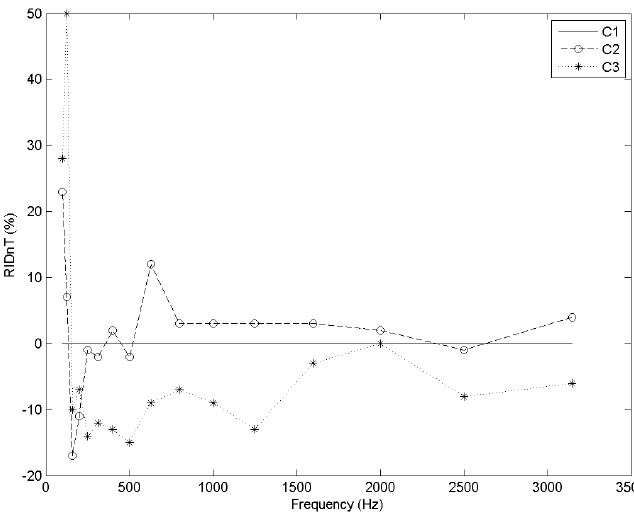
Figure 10. RID nT (%) vs. frequency (Hz) for each cell type.